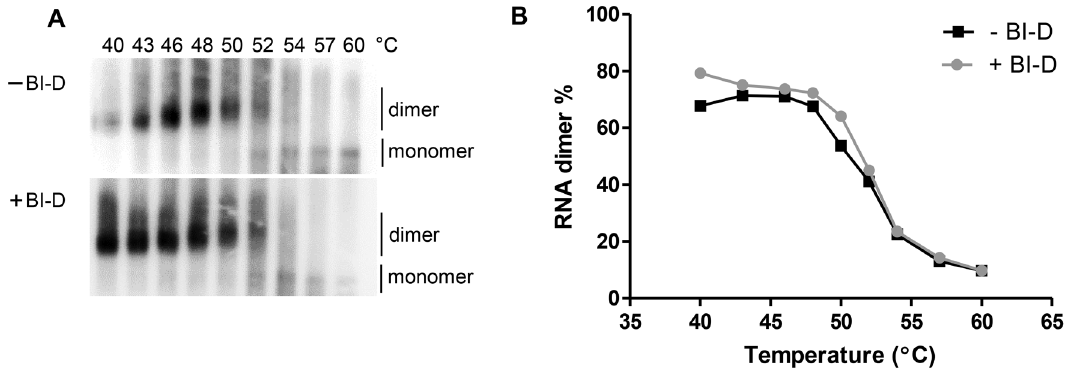
Figure 3. Thermal stability of HIV-1 RNA dimers from viruses cultured in the presence or absence of BI-D. A. Virion-derived RNA was heated for 10 min at increasing temperatures (40, 43, 46, 48, 50, 52, 54, 57 and 60 u C) before analysis on a non-denaturing northern blot. The dimer and monomer positions are indicated. B. The monomer and dimer RNA bands observed in panel A were quantified to calculate the level of RNA dimerization at each temperature.